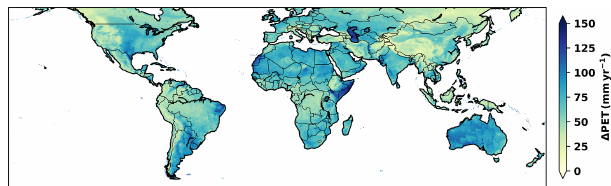
Figure 14. The global climatological step change in annual PET due to a unit temperature increase. The results were obtained by taking the difference between the PET, calculated with increased tempera- ture, and hPET, which is calculated using the current